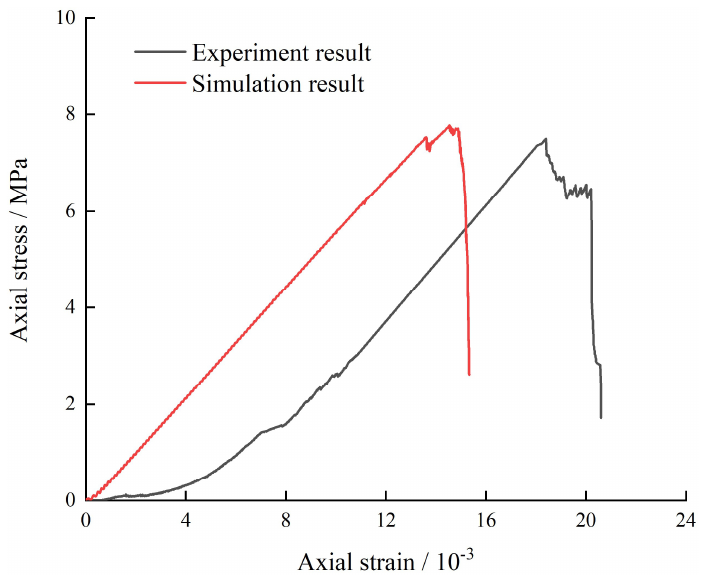
Figure 9. Comparison between the numerical simulations and experimental results.